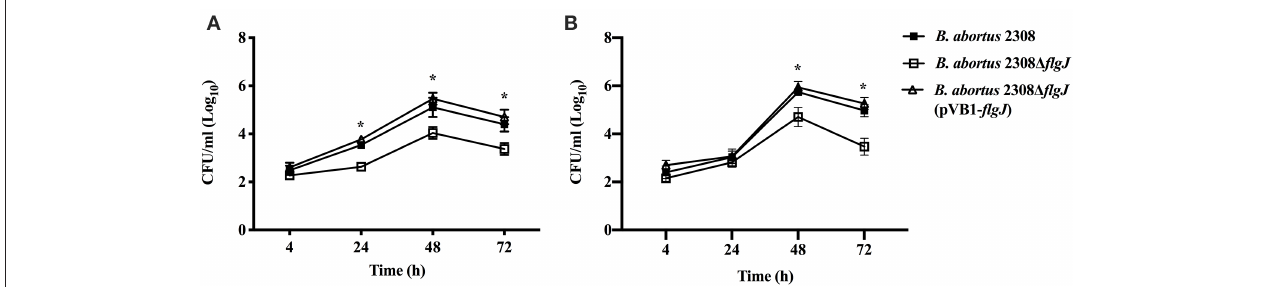
FIGURE 4 | Intracellular survival of B. abortus 1 flgJ in professional and non-professional phagocytes. (A) J774.A1 macrophages were infected at MOI of 50:1. B. abortus 2308 (open triangle), B. abortus 1 flgJ (open square), and complemented B. abortus 1 flgJ (pBV1- flgJ ) (closed square). (B) HeLa cells were infected at MOI of 500:1. Results correspond to a representative experiment from two separate experiments. For each time point and each strain results are expressed as means ± standard deviation. * P < 0.05 when compared to parental B. abortus